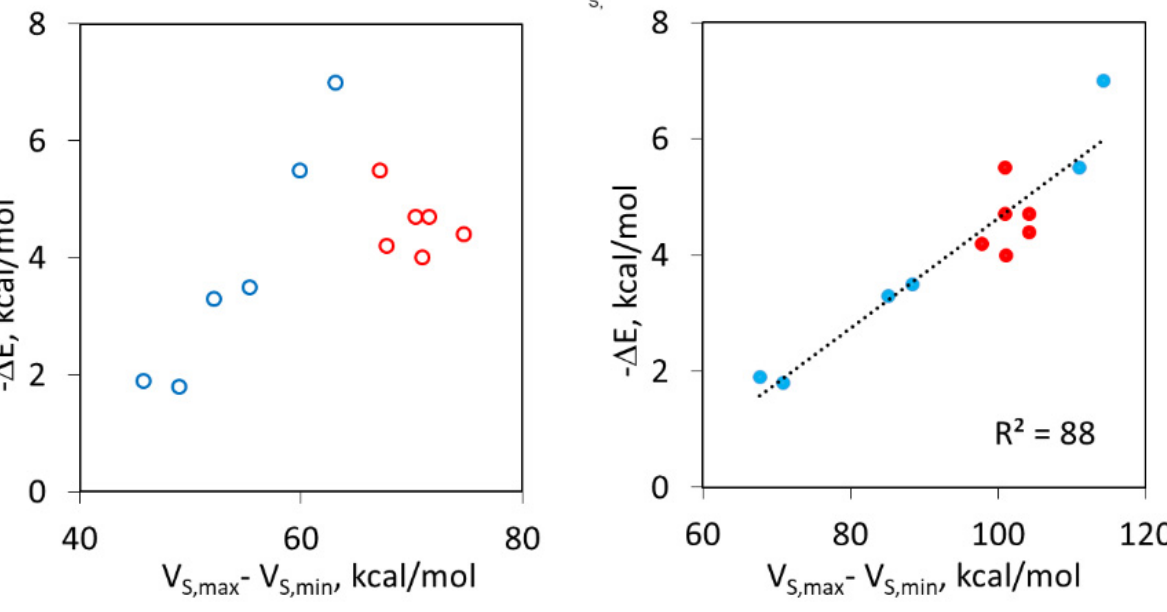
Figure 9. Correlations between the interaction energies in the XB and HB complexes (blue and red circles, respectively) with DABCO and TMPD and the difference of the electrostatic potentials on the surfaces of interacting atoms in the individual molecules ( left ) and in polarized molecules ( right ).